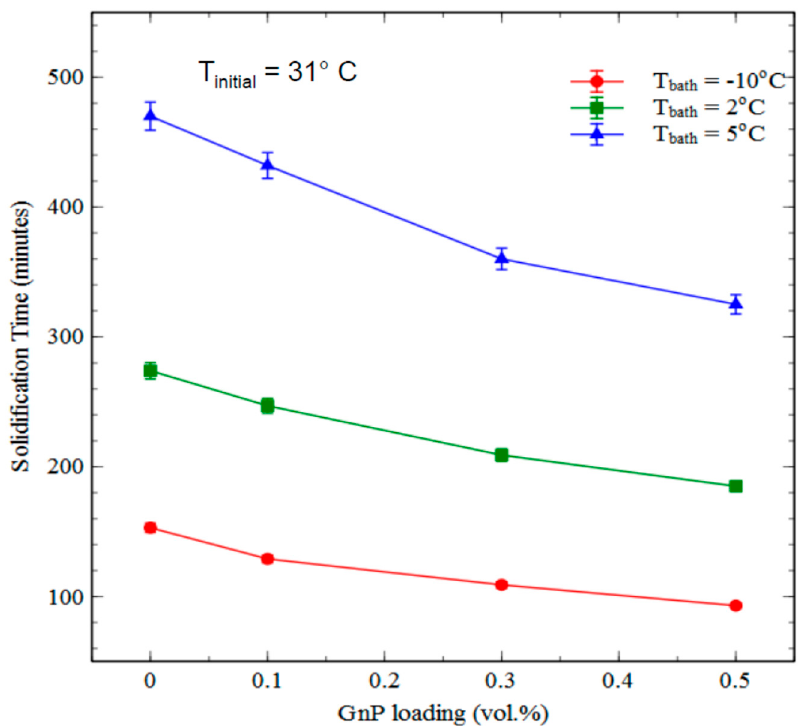
Figure 10. Solidification time of the PCM nanocomposites for various bath temperatures.